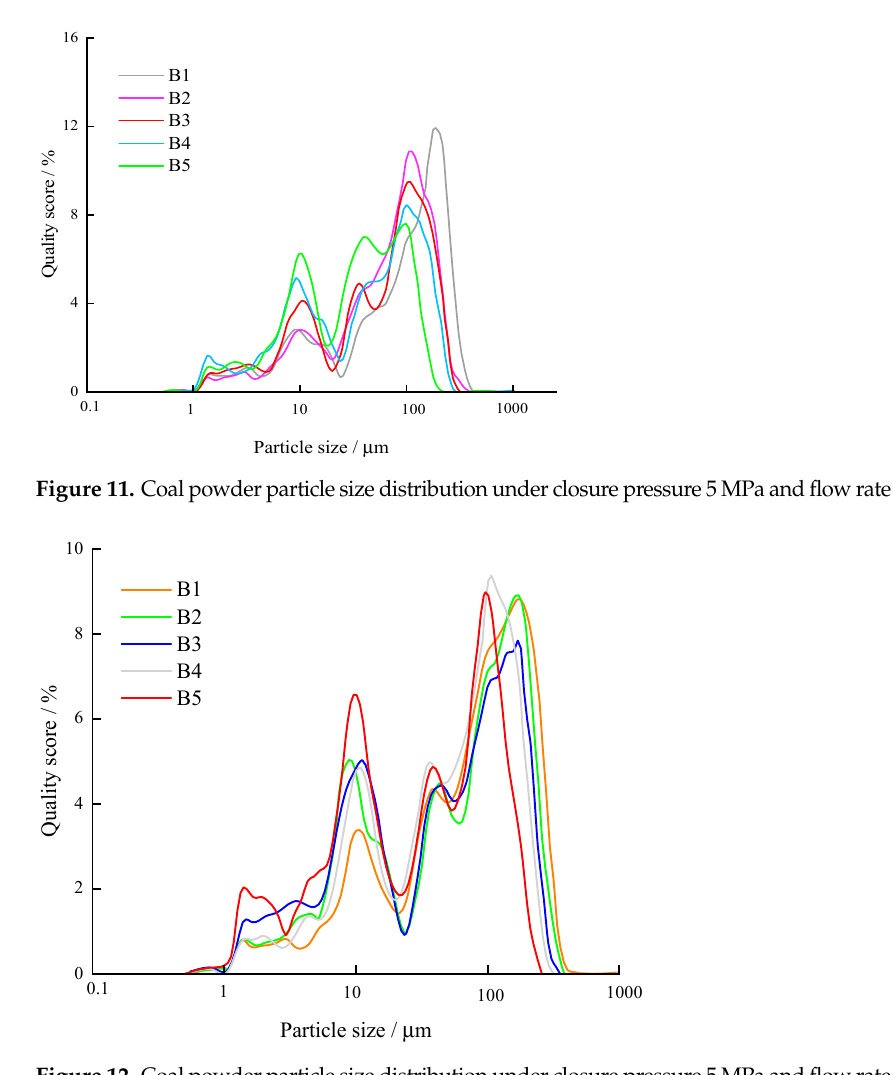
Figure 12. Coal powder particle size distribution under closure pressure 5 MPa and flow rate 200 mL/min.